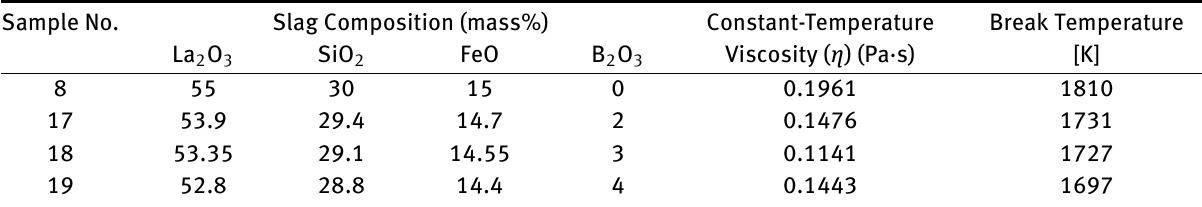
Table 4: Constant-Temperature Viscosity and Break Temperature of La 2 O 3 -SiO 2 -FeO–B 2 O 3 Slag. Sample No.